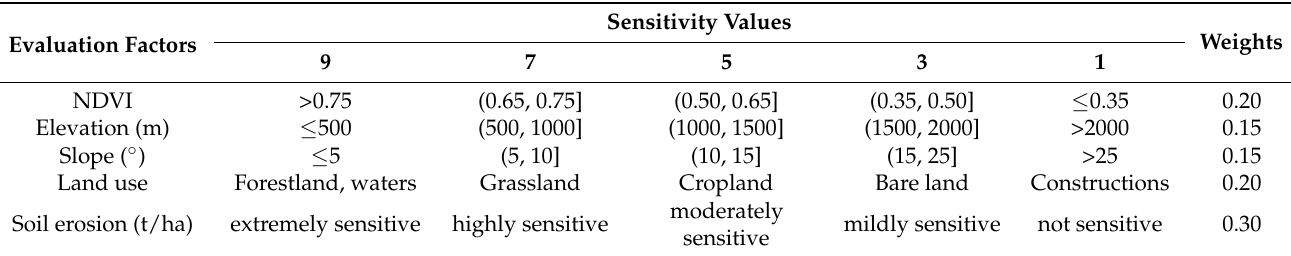
Table 2. Grading and weighting of ecological sensitivity evaluation